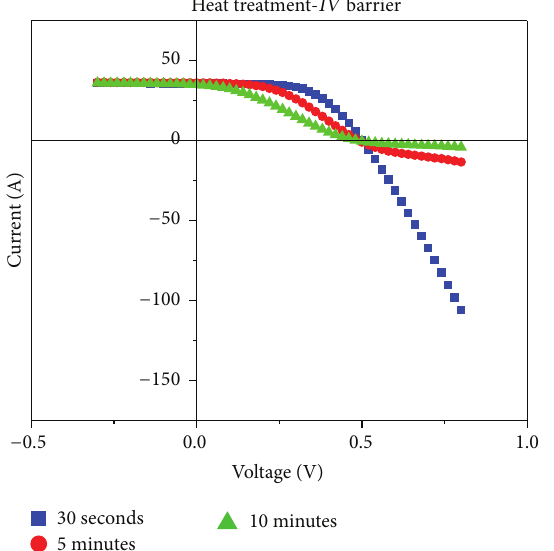
Figure 6: The slope of the IV curve is a method to estimate the series resistance increase and consequently the barrier formation. In squares exposure of 30 seconds, in circles 300 seconds, and in triangles 600